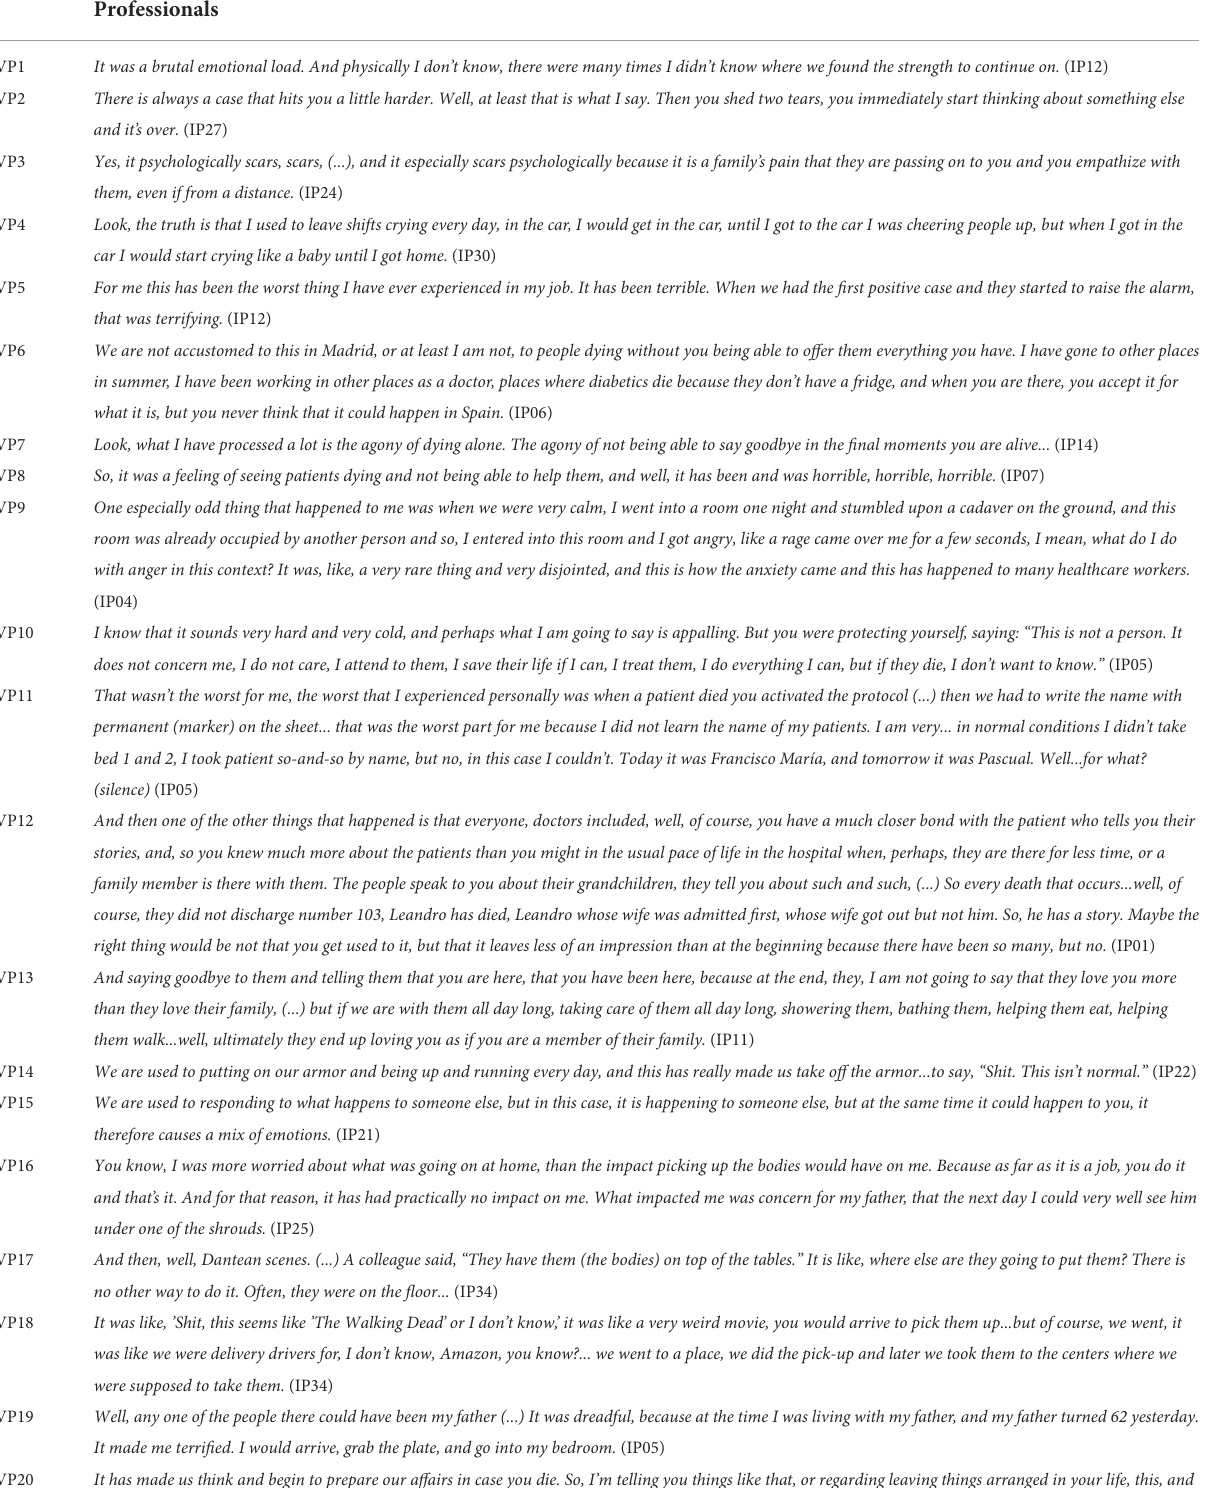
TABLE 3 Verbatin of the interviews illustrating the results obtained, classified into responses from professionals and responses from family members: Madrid. Spain 2021. Verbatim